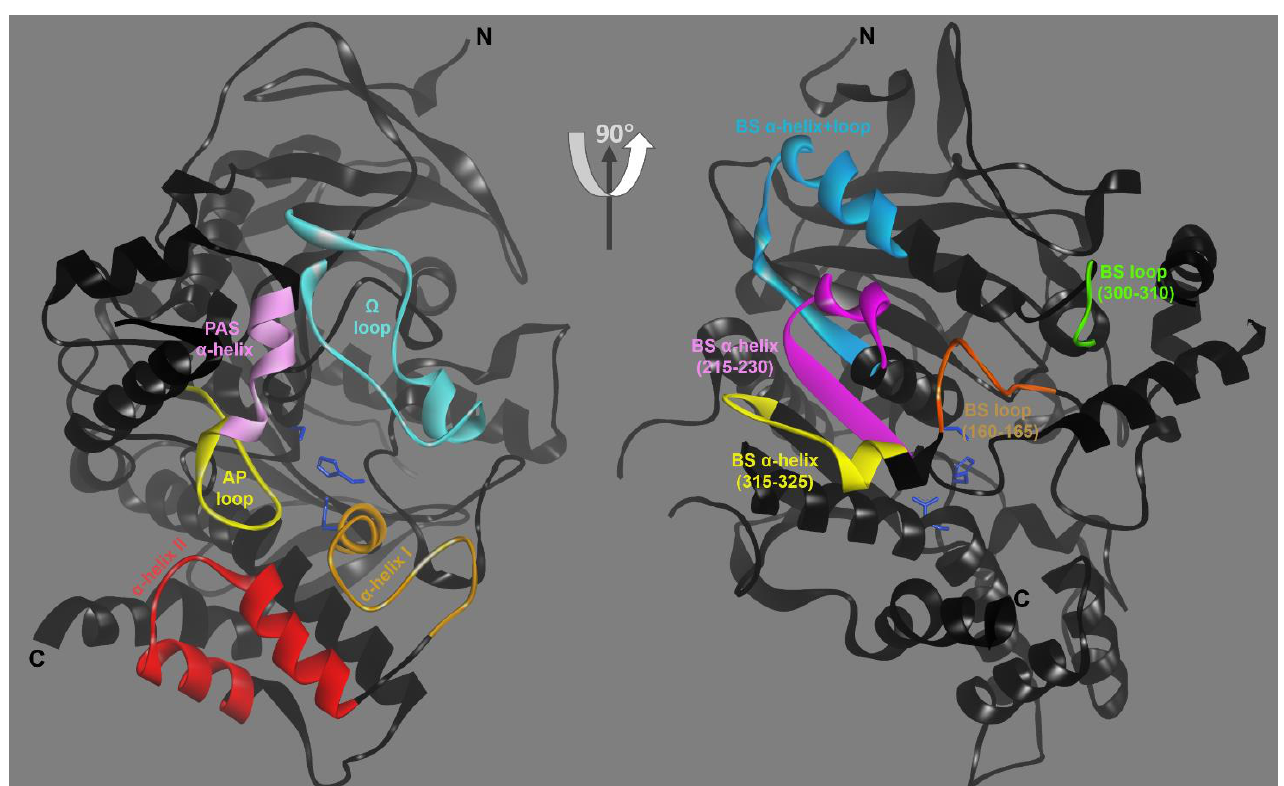
Figure 5. Location of structural elements of hAChE backbone affected by OP conjugation, as detected by PACCT 3 analysis (Figures 4 and 6, Table 1), shown in the ribbon representation of the X-ray structure of Apo-hAChE (PDB ID 4EY4). Two different sets of elements are shown. Left panel : those surrounding the opening of the active center gorge (AP loop, PAS α - helix, Ω - loop, and α -helices I and II). Right panel : Backside Surface (BS) elements, BS loops (160 – 165 and 300 – 310), BS α -helices (215 – 230 and 315 –325) and BS α -helix+loop. Catalytic triad Ser203, His447 and Glu334 are rendered as blue sticks. Table 1. Summary of effects of OP conjugation of hAChE and of consecutive, reversible HI6 binding, as evaluated by PACCT 3 from pairwise comparisons of listed X-ray structures with Apo-hAChE (4EY4). Identities of the acyl pocket (AP) stabilized substituents (AP group) on phosphorus atoms for each OP conjugate are given as observed from corresponding X- ray structures. Listed in the table are magnitudes of Cα shifts identifie d in Figures 4 and 6 as significant, from weak (+) to very significant (++++). Locations of ten identified elements in the hAChE Cα backbone are shown in Figure 5. All analyzed structures were of the same space group, P 3 1 2 1.